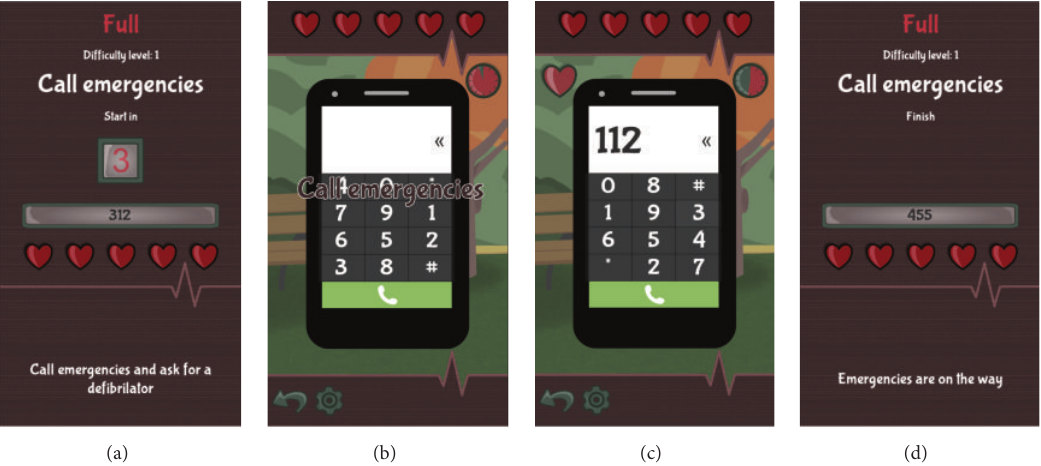
Figure 8: Game screens corresponding to the Ask for Help. (a) Init screen with game instructions. (b) Main screen with phone numbers and (c) once the player has dialed the correct number. (d) Final screen with the obtained score and the message that help and defibrillator are on the way.